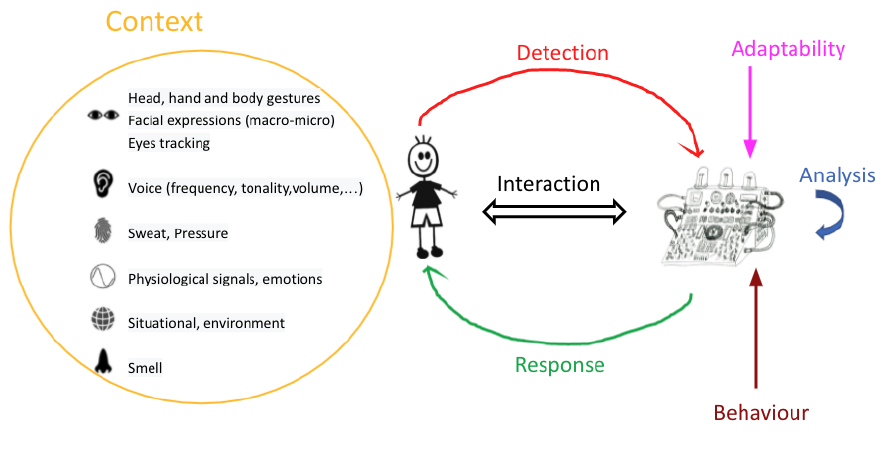
Figure 10. Empathic user